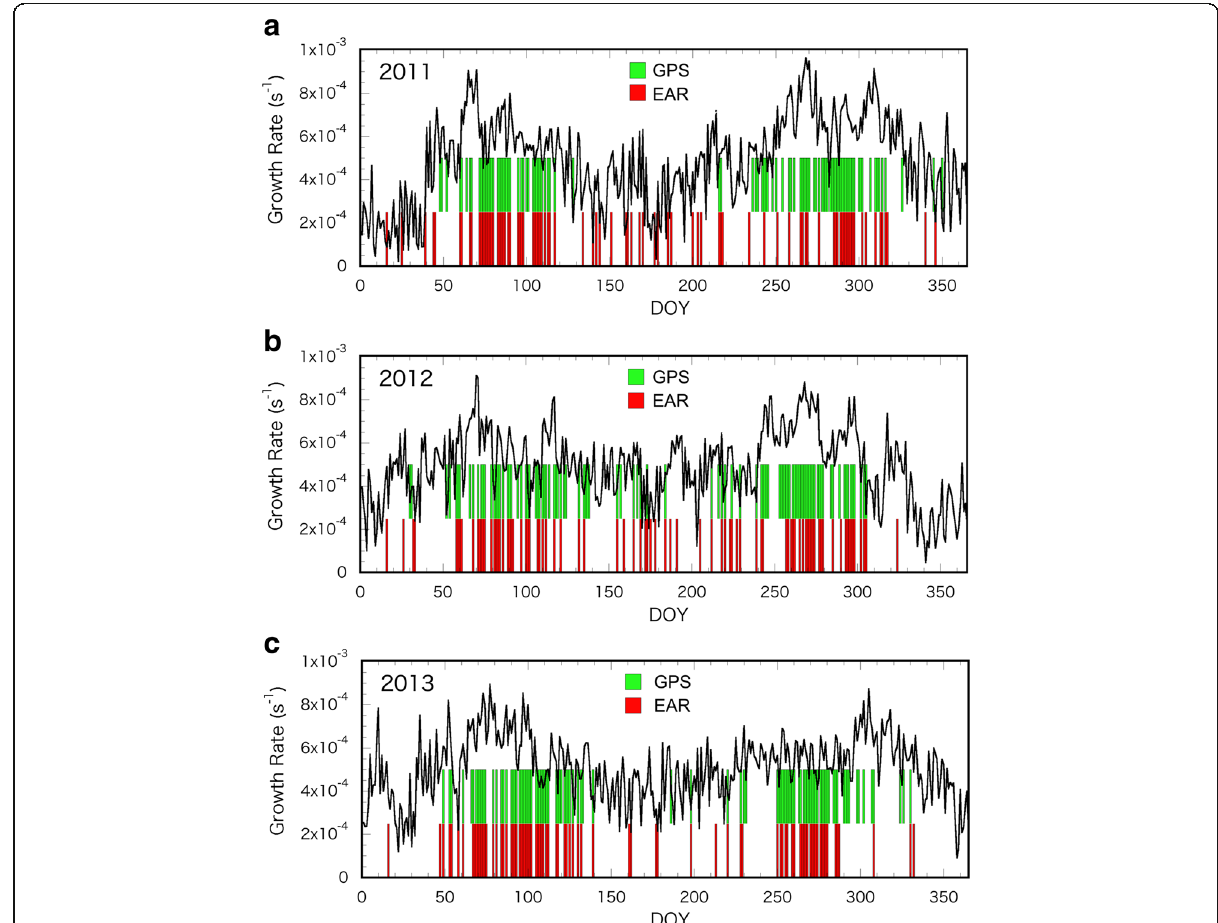
Fig. 2 Daily variations in R-T growth rate obtained with GAIA. The daily maximum values of the R-T growth rate (black line) are obtained with GAIA at 100°E for the years of a 2011, b 2012, and c 2013. Vertical bars indicate the days when EPBs are detected by EAR (red bar) and by GPS (green